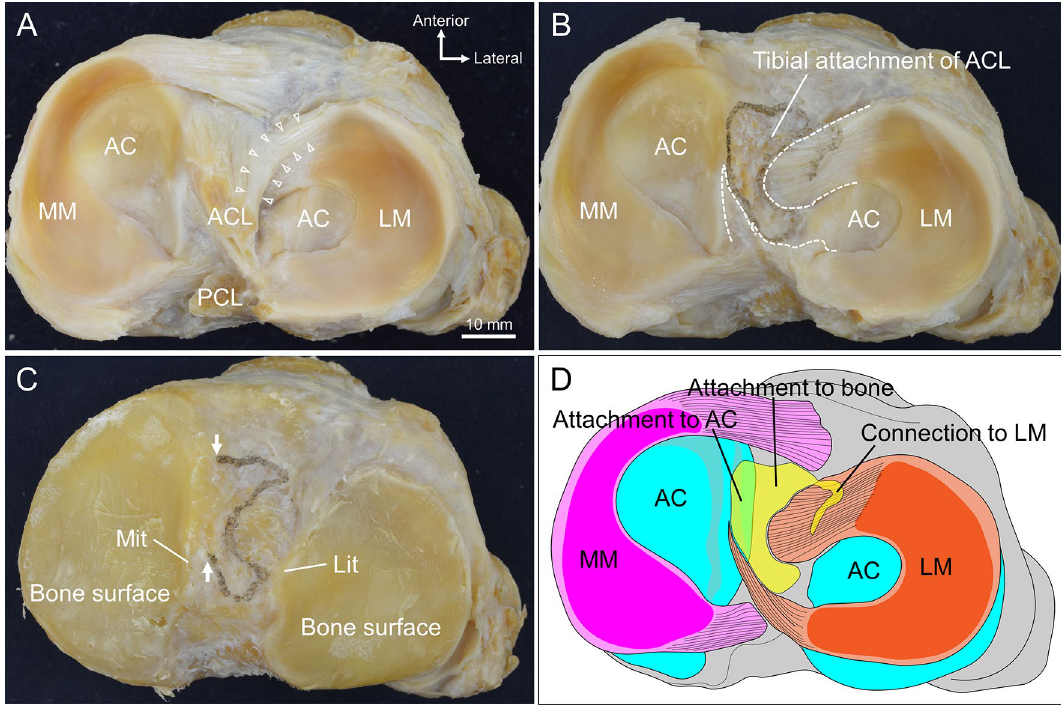
Figure 1. The attachment of the tibial side of ACL. ( A ) The superior aspect of the tibial side of the ACL. A few ACL fibers are connected to the anterior horn of LM (arrowheads). ( B ) After removing the ACL, while marking the margin of its attachment with a black pen. The lateral and posteromedial borders of the ACL attachment coincide with the edge of the anterior and posterior horns of LM, respectively. ( C ) After removing the menisci and articular cartilage. The marking line on the medial border of the ACL attachment disappeared (arrows), implying that the ACL is medially attached to the articular cartilage. ( D ) Summary of the attachments of the tibial side of ACL, comprising an attachment to the bone, articular cartilage, and LM. AC, articular cartilage; ACL, anterior cruciate ligament; Lit, lateral intercondylar tubercle; LM, lateral meniscus; Mit, medial intercondylar tubercle; MM, medial meniscus; PCL, posterior cruciate ligament.